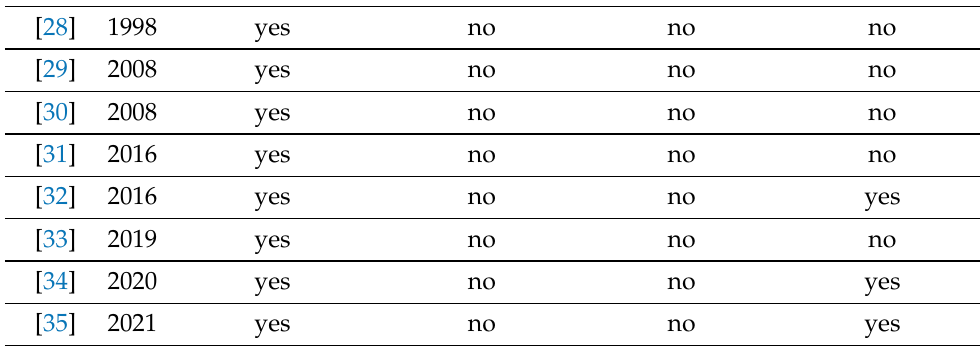
Table 1. Summary of existing